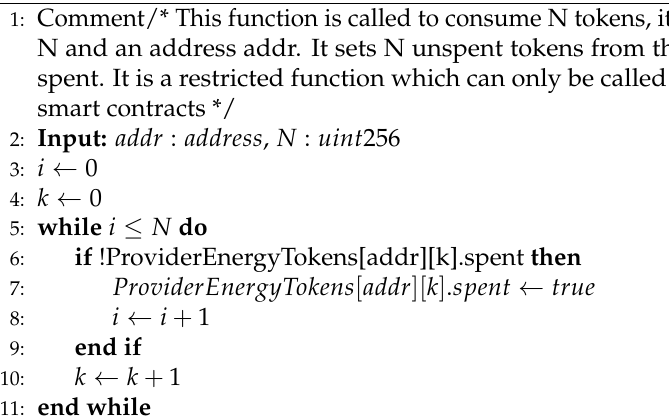
Algorithm 7 DSO Smart Contract: